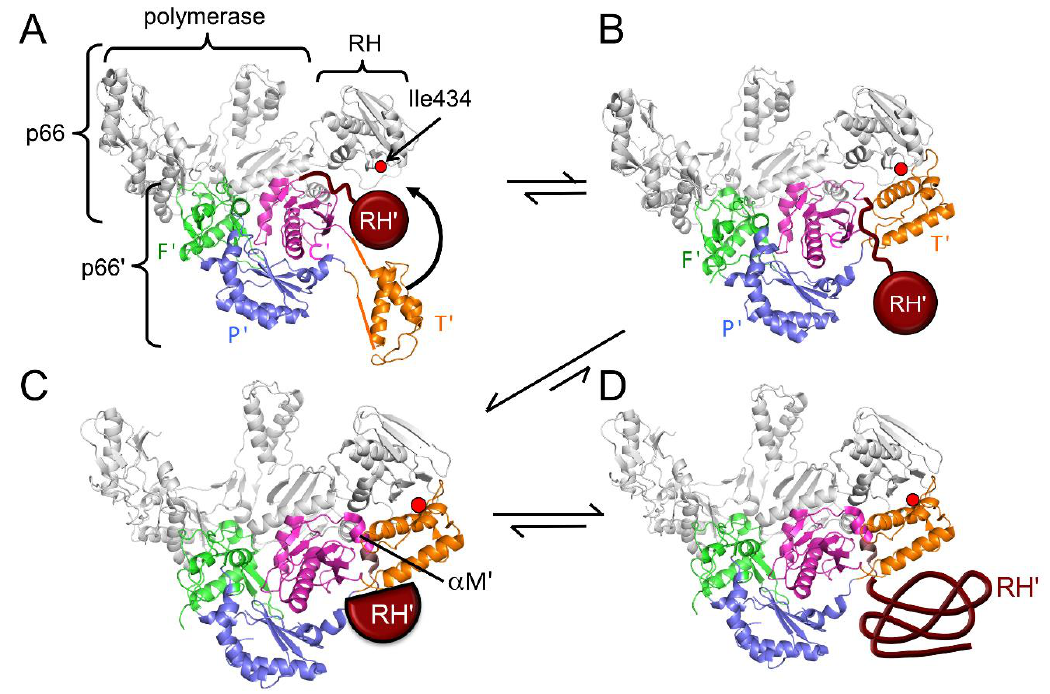
Figure 10. Maturation processes that follow dimer formation. ( A ) Schematic ribbon diagram of an early monomer in which the p51 subunit of the heterodimer has been replaced by p66 M (Figure 4B) and the RH’ domain is represented by a brown circle; ( B ) Schematic of the RT heterodimer subsequent to formation of the RH:thumb’ (T’) interface and repositioning of the connection’ (C’) linker and RH’ domain; ( C ) Schematic showing a more mature form of the homodimer in which helix α M’ is fully formed and RH’ has become destabilized as a result of the loss of several N-terminal residues; ( D ) Schematic of the final structure of the p66/p66’ homodimer after RH’ unfolding. In the above structures, the p66 subunit is shown in gray and the domains of the p66’ subunit are color coded as in Figure 2. Although no RT ligands are assumed, the p66 subunit conformation is based on a structure with an open fingers (F’)/thumb (T’) conformation for clarity. Transitions of the polymerase’ domain in the p66’ subunit correspond to the monomeric ( M ) → compact ( C ) structures shown in Figure 3A. The location of the p66 Ile434 residue—which provides a resonance sensitive to the formation of the RH:T’ interface—is indicated.